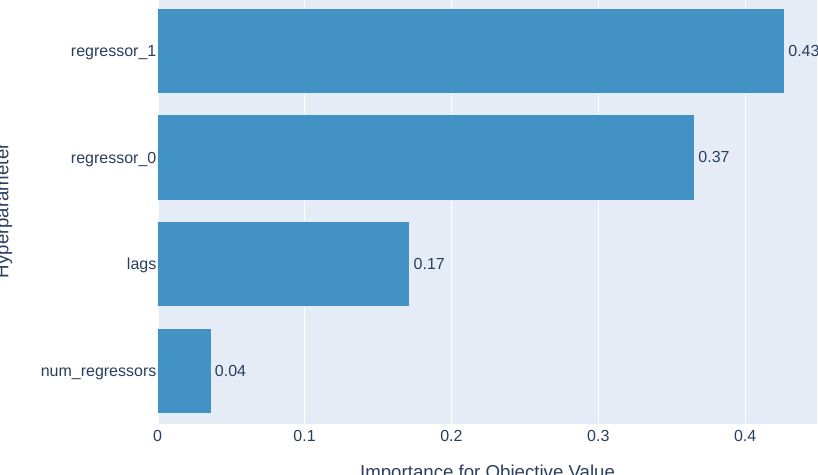
Figure 7. Importance of the parameters.